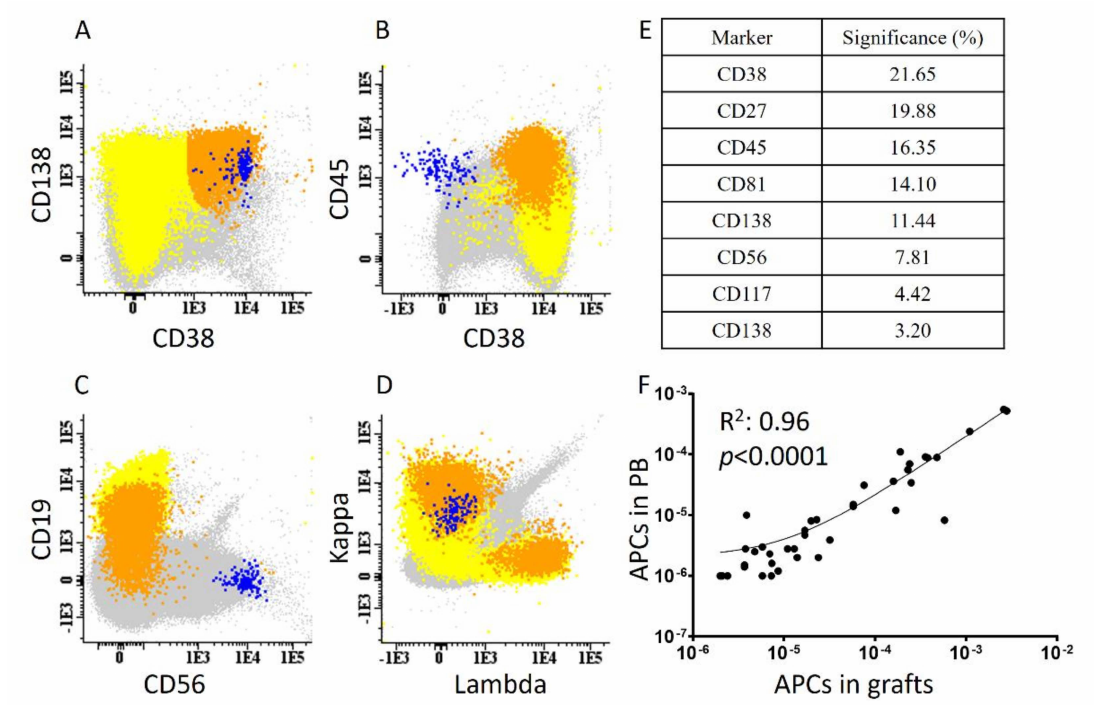
Figure 1. Detection of aberrant plasma cells (APCs) with next-generation flow cytometry. ( A – D ): Representative con+ sample with a clear subset of APCs at the level of 10 − 5 (blue). The normal plasma cell compartment is shown in orange, B cells in yellow and all other nucleated cells in grey. ( E ) Relevant significance of different markers used for the discrimination of APCs (cumulative mean values of n = 79 con+ cases). ( F ) Linear correlation between the percentage (%) of APCs detected in stem cell grafts and 41 matched peripheral blood (PB)